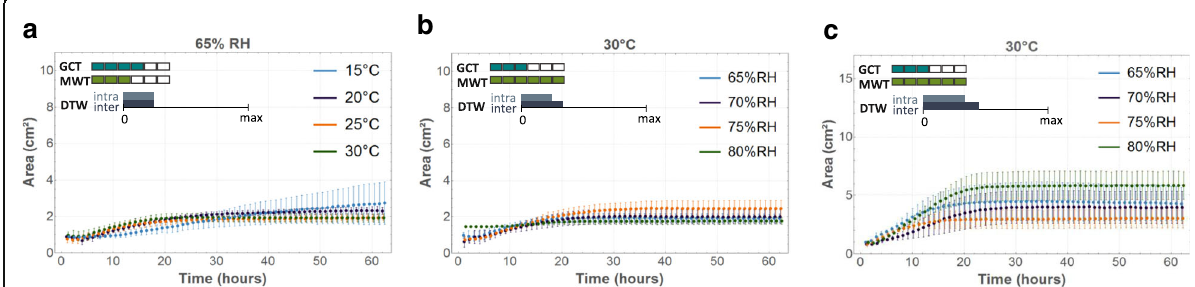
Fig. 6 Evolution of mycelial area (cm 2 ) over time for C. puteana at 65% RH ( a ) and 30 °C ( b ) and R. solani at 30 °C ( c ), showing limited growth. The dots represent the mean values over four replicates, with the bars indicating the standard deviation. For each graph, six pairwise GCT and MWT were performed between the four conditions represented in that graph. The two colour scales indicate for how many of those pairwise comparisons a difference was found according to GCT (blue) and MWT (green). The third scale represents the difference between the average DTW distance between the four conditions represented in the graph and a reference ground value, being the average DTW distance over the replicates in that graph. The bigger the bar, the more difference there is between conditions. When the DTW scale is negligibly small, the difference between conditions is insignificant compared to the reference DTW difference between replicates